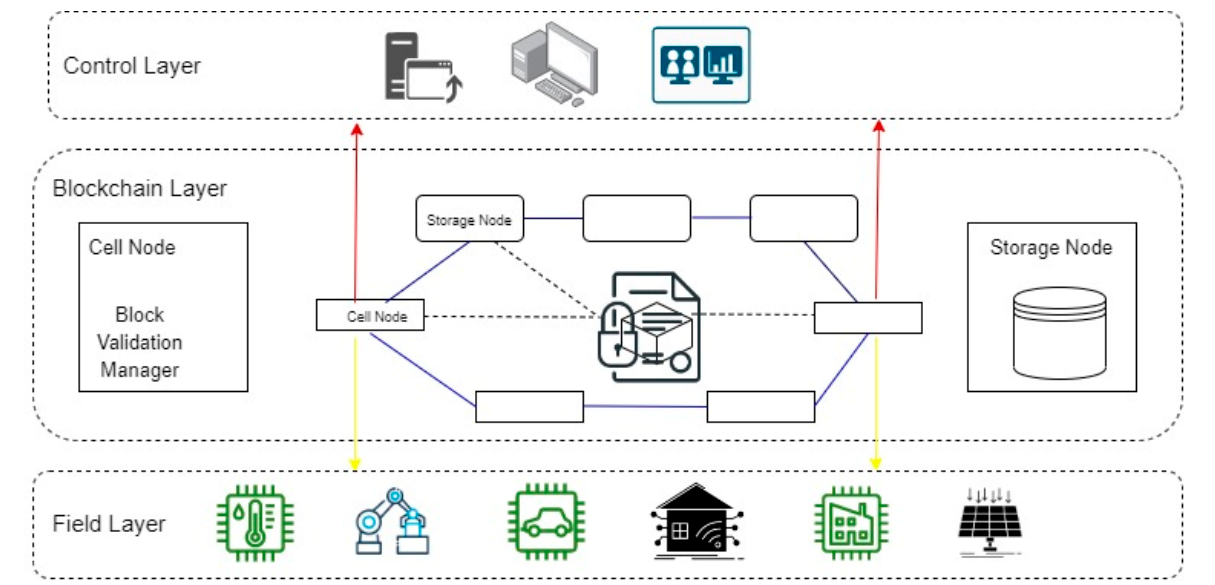
Figure 3. Hash-based Blockchain architecture.